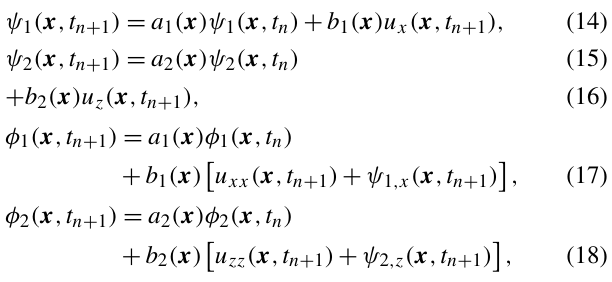
The auxiliary functions will also be kept at zero over all the outer boundary of (cid:127)